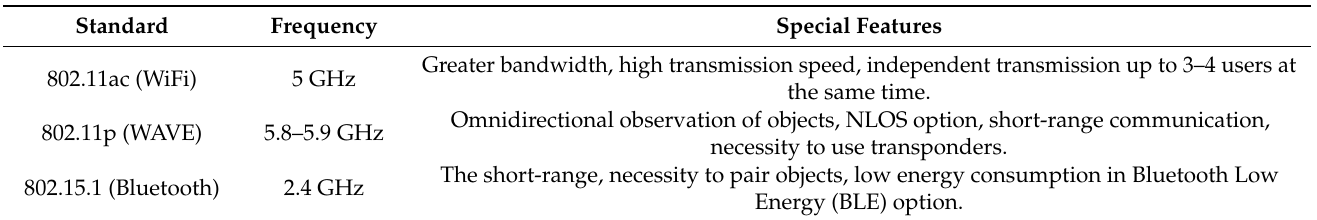
Table 1. Summary of chosen IEEE standards and their unique features for robot companion communication. Standard Frequency Special